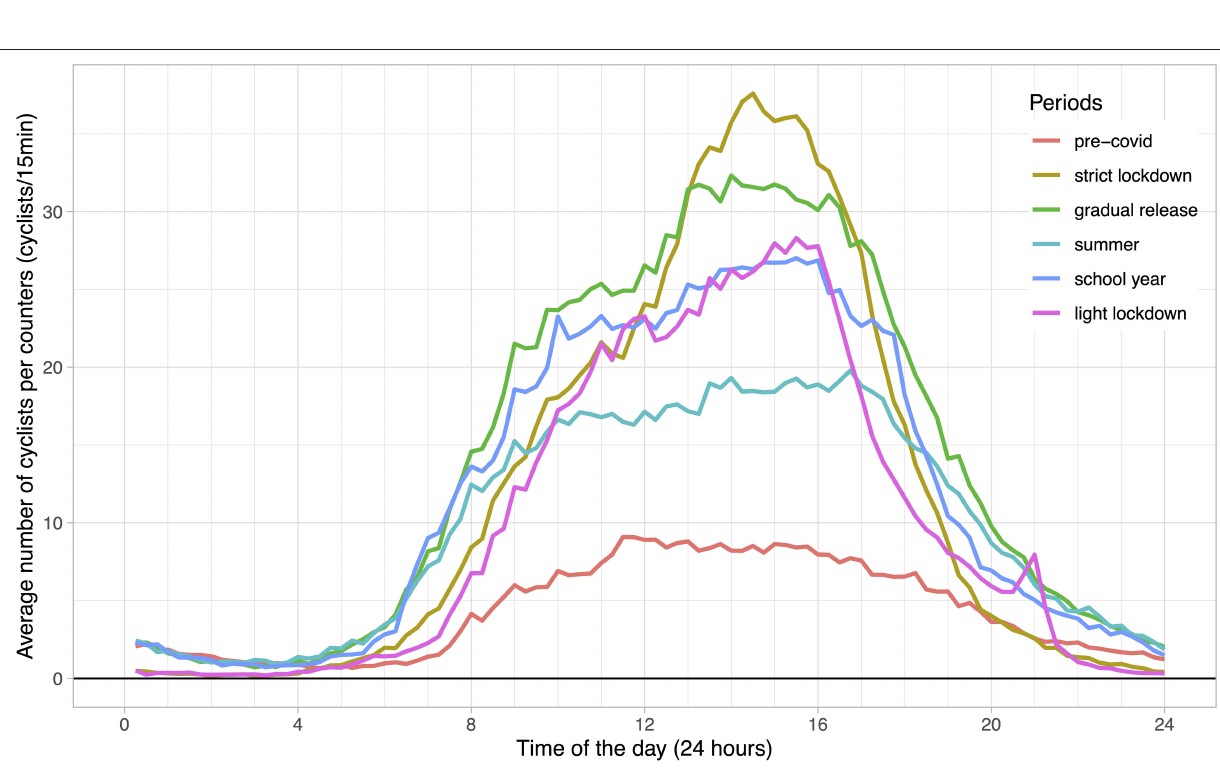
Frontiers in Sustainability |